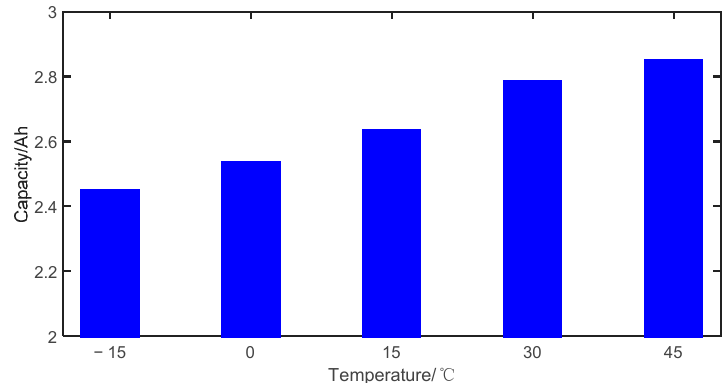
Figure 6. The discharge capacity of batteries under five temperature conditions.